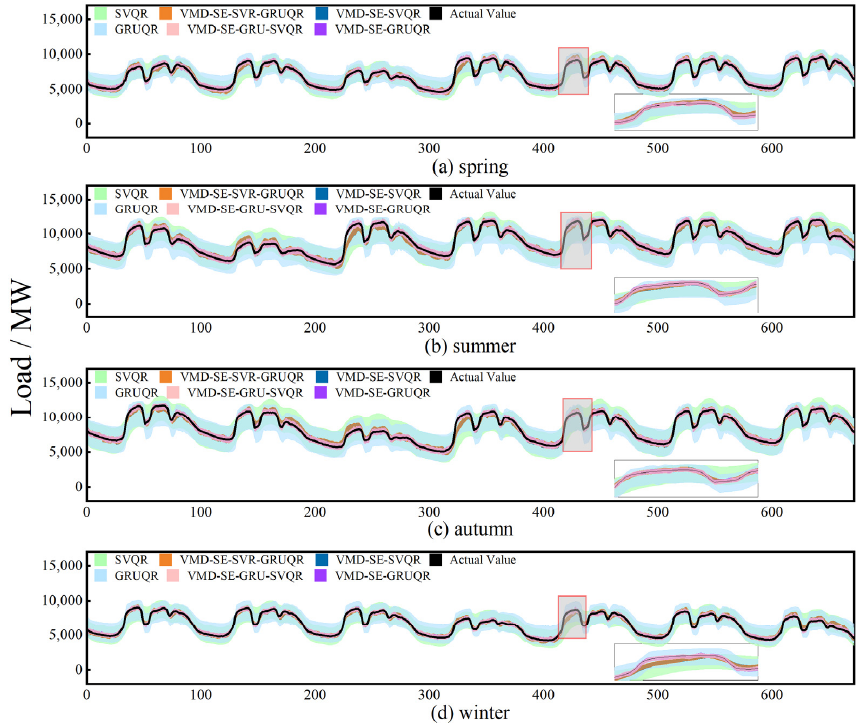
Figure 9. Forecasting results of dataset A at 90 confidence level.